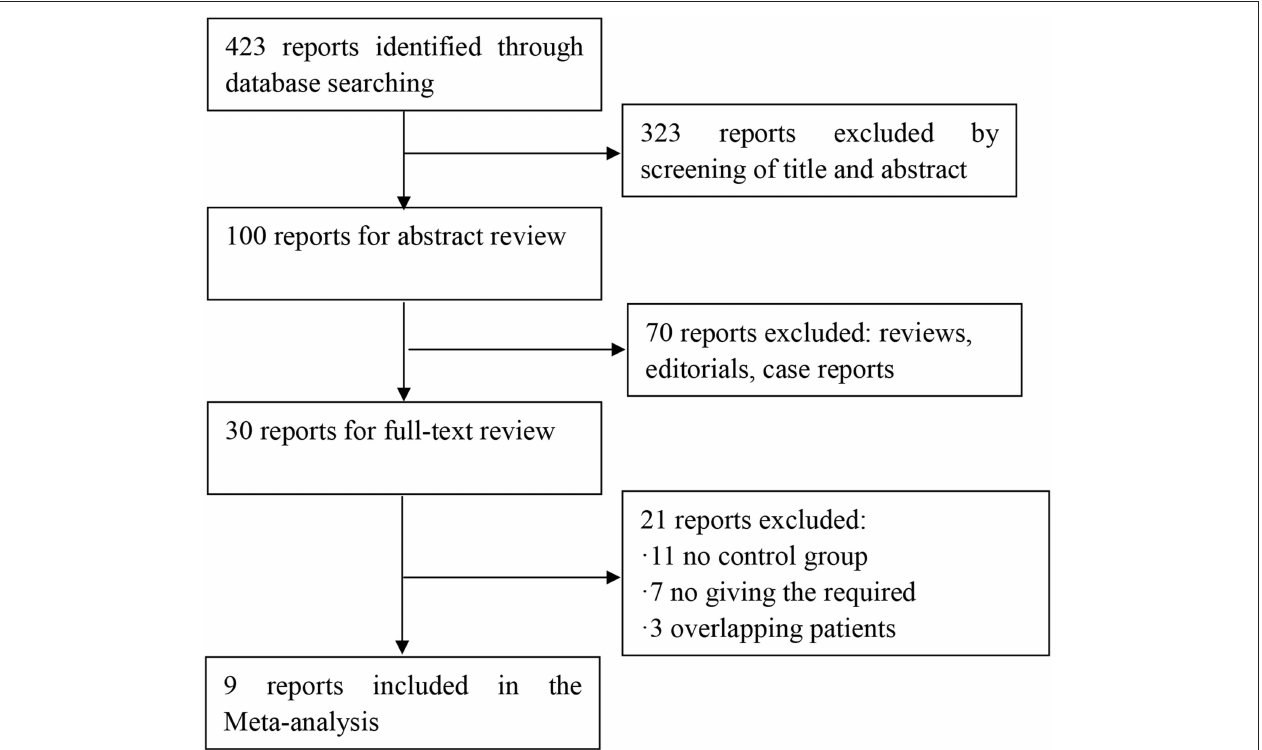
FIGURE 1 | Flow chart for article